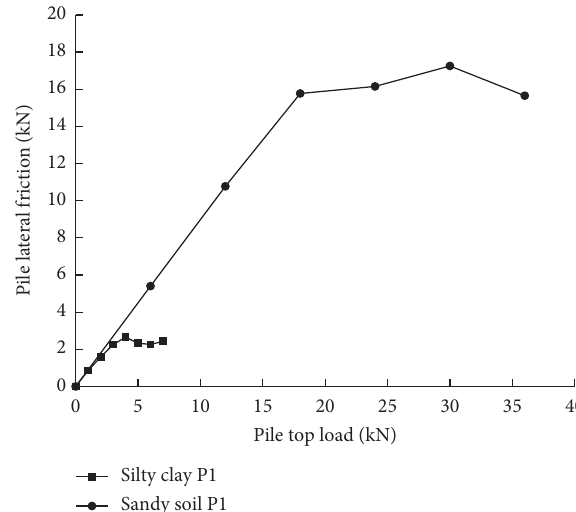
Figure 6: The lateral friction of pile in different soils along with load